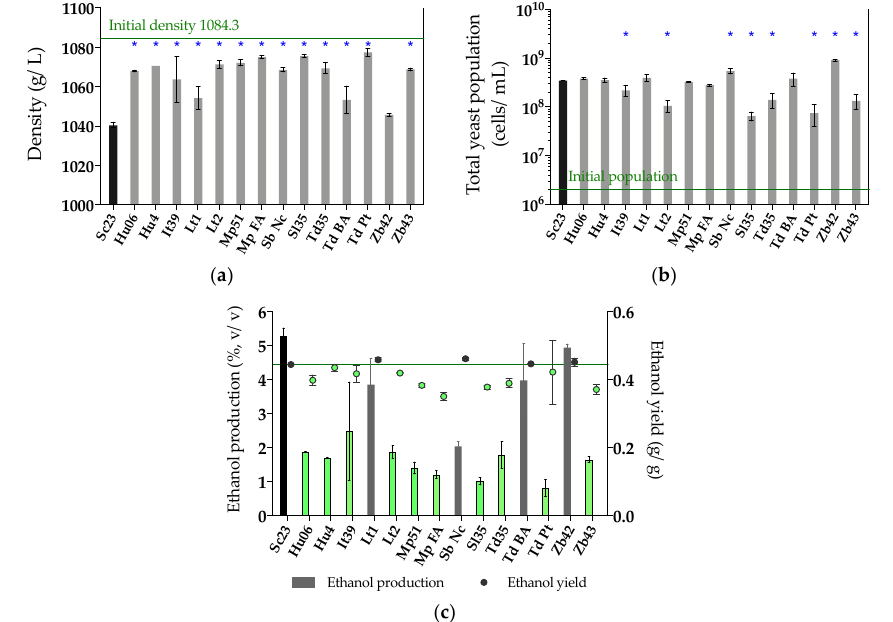
Figure 2. ( a ) Density (g/L); ( b ) Total yeast population (cells/mL); ( c ) Ethanol production (%, v/v) and ethanol yield (g/g) at 48 h of single fermentation in synthetic must. Non‐ Saccharomyces yeasts selected for the next step are colored in green, with the ethanol yield below that of Sc23 (0.44 g/g, the value of the green line in Figure ( c )). Asterisk (*) means the significant difference compared with Sc23 (LSD, p < 0.05).